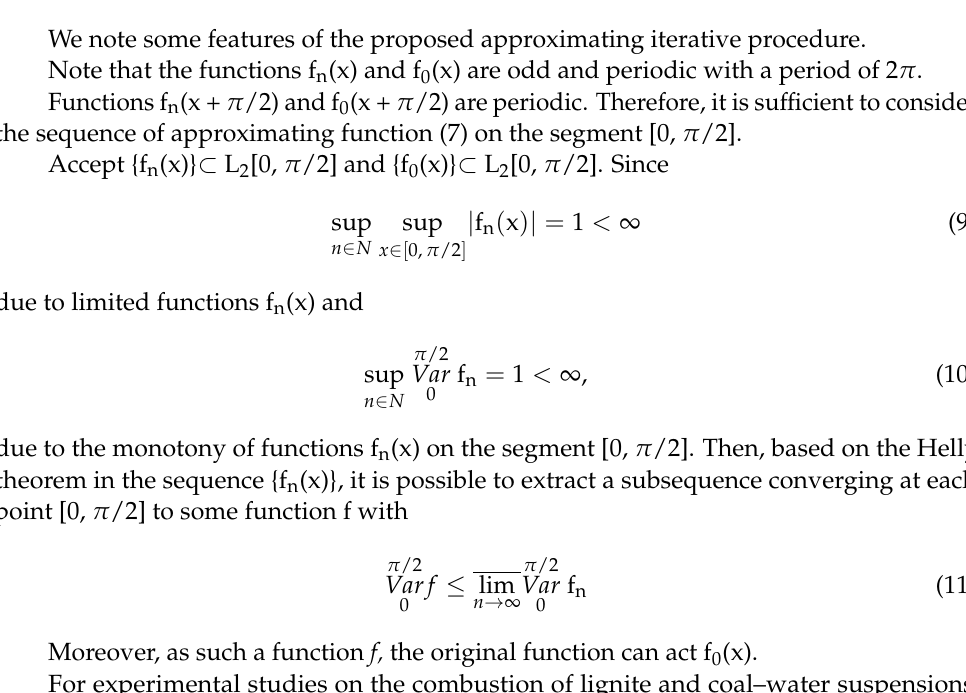
Figure 2. Graphs of the original function and its five successive approximations.